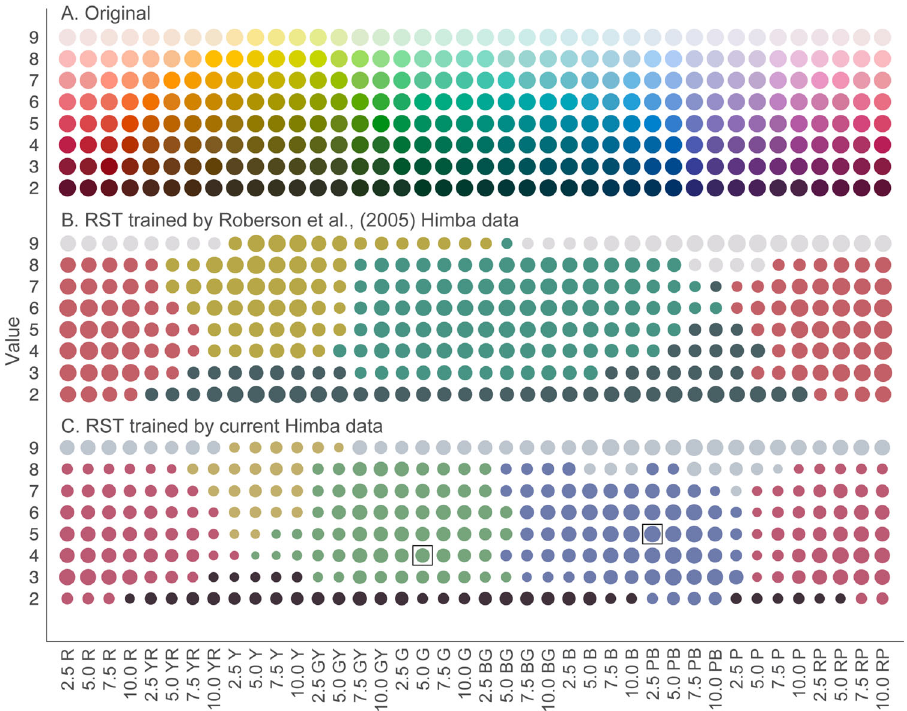
Fig. 3 A Simulated Munsell array ( n = 320 chips) of hue (horizontal axis) against value/lightness (vertical axis) with each disc having equal size (top). B Segmentation of Munsell array by RST into fi ve Himba colour terms (burou 30.0%, serandu 26.9%, zoozu 17.5%, dumbu 16.3% and vapa 9.4%) based on data of Roberson et al. (2005) (middle) and C into 6 Himba terms (serandu 28.1%, burou 20.6%, grine 19.4%, vapa 13.4%, zoozu 11.3% and dumbu 7.2%) based on Himba data of the new study (bottom). Disc size corresponds to the con fi dence of classi fi cation by the RST algorithm for the old and new data. The colour of each disc corresponds to the centroid of each colour term. Black square outlines show the location of green and blue foci in English (Sturges and Whit fi eld,